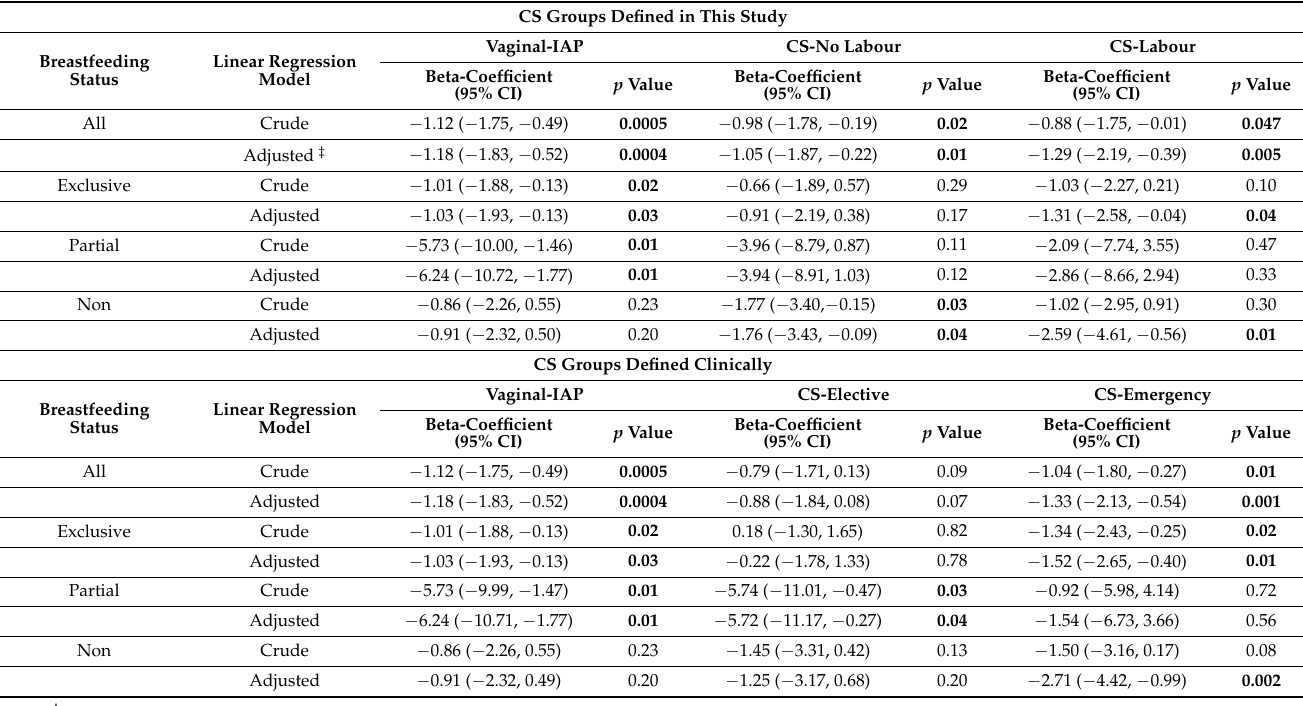
Table S2). When testing the clinical categories of elective and emergency CS delivery, which were employed in our previous study [14], some differences in the relative abundance of qPCR bifidobacteria were found (Table S2). With exclusive breastfeeding, elective CS delivered infants had 5.29% of Bifidobacterium , while infants born by emergency CS had 1.63% of this genus in their faecal gut microbiota ( p < 0.05, measured by qPCR, Table S2). The relative abundance of qPCR bifidobacteria was also higher in elective CS vs. vaginal IAP. These differences were no longer evident when CS delivery was re-grouped as CS with and without labour (Table S2). No statistically significant differences were found when CS without labour was compared to elective CS birth, or CS with labour to emergency CS birth (Table S2). Independent Associations between Bifidobacteria , B. longum subsp. infantis and Birth Mode In linear regression models predicting the Box–Cox transformed absolute quantity of bifidobacteria, crude beta-coefficients were statistically significant for vaginal delivery with maternal IAP exposure ( p < 0.05 for all infants, Table 2), indicating a lower absolute quantity of gut bifidobacteria vs. the reference group of vaginal birth with no IAP. This association persisted following adjustment for maternal BMI ( p < 0.05, Table 2). For comparisons quantity were observed between IAP and no IAP in vaginally delivered infants who were exclusively (crude beta-coefficient, c β : − 1.01; adjusted beta-coefficient, a β : − 1.03, p < 0.05, Figure 2 and Table 2) and partially breastfed (c β : − 5.73, a β : − 6.24, p < 0.05, Figure 2 and Table 2). CS delivery, regardless of labour, and emergency CS were also associated with reduced absolute quantities of bifidobacteria, independent of BMI ( p < 0.05 for all infants, Table 2). BMI-adjusted associations were seen for CS with or without labour in non-breastfed infants ( p < 0.05, Table 2). BMI adjustment revealed statistically significant reductions in absolute quantities of bifidobacteria for CS with labour or emergency CS among exclusively breastfed or non-breastfed infants ( p < 0.05, Table 2). Table 2. Associations between birth mode and the absolute quantity of genus Bifidobacterium by qPCR analysis, all and stratified by feeding status †